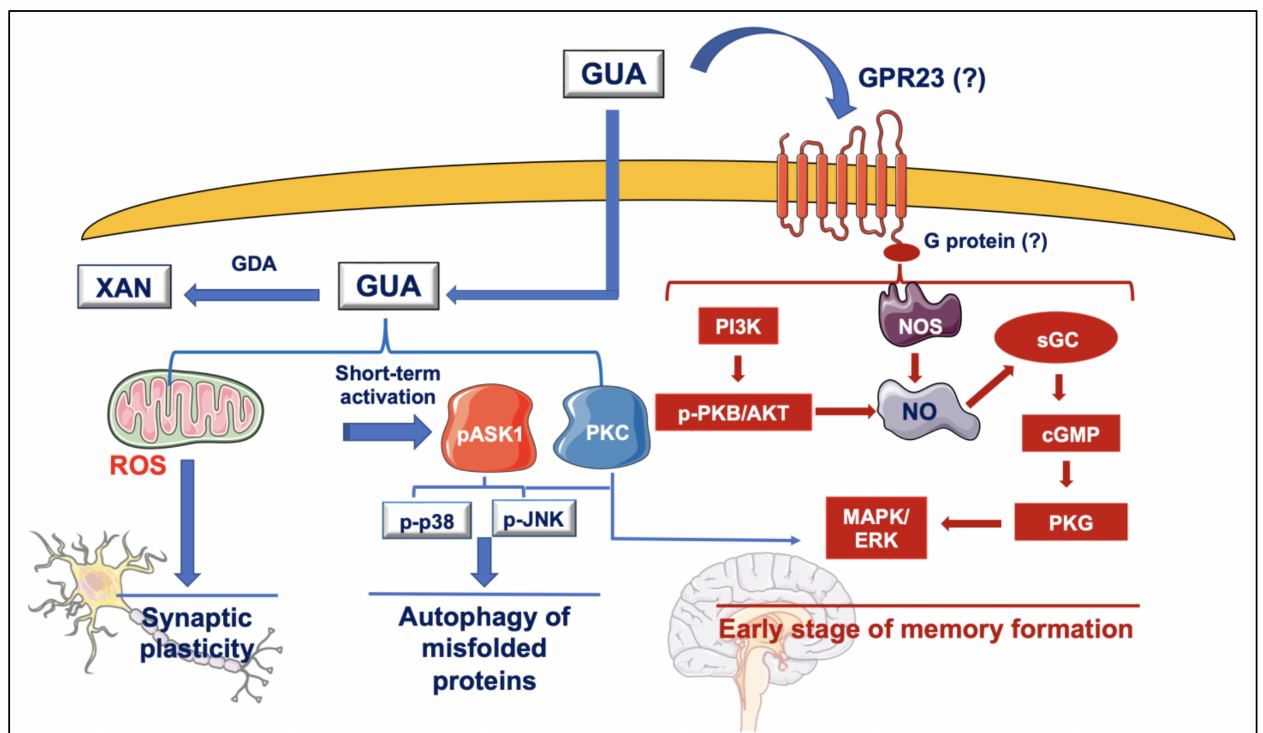
Figure 2. Scheme of the molecular pathways activated by SH-SY5Y neuroblastoma cell exposure to GUA, as reported in [39]. Abbreviations: cGMP, cyclic GMP; GDA, guanine deaminase; GUA, guanine; MAPK/ERK, mitogen-activated protein kinase/extracellular signal-regulated kinase; NO, nitric oxide; NOS, nitric oxide synthase; p-ASK1, phosphorylated apoptosis signal-regulating kinase 1; p-JNK, phosphorylated c-Jun N-terminal kinase; p-p38, phosphorylated p38 kinase; p-PKB, phos- phorylated protein kinase B; PI3K, phosphoinositide-3 kinase; PKC, protein kinase C; PKG, protein kinase G; ROS, reactive oxygen species; sGC, soluble guanylate cyclase; XAN,